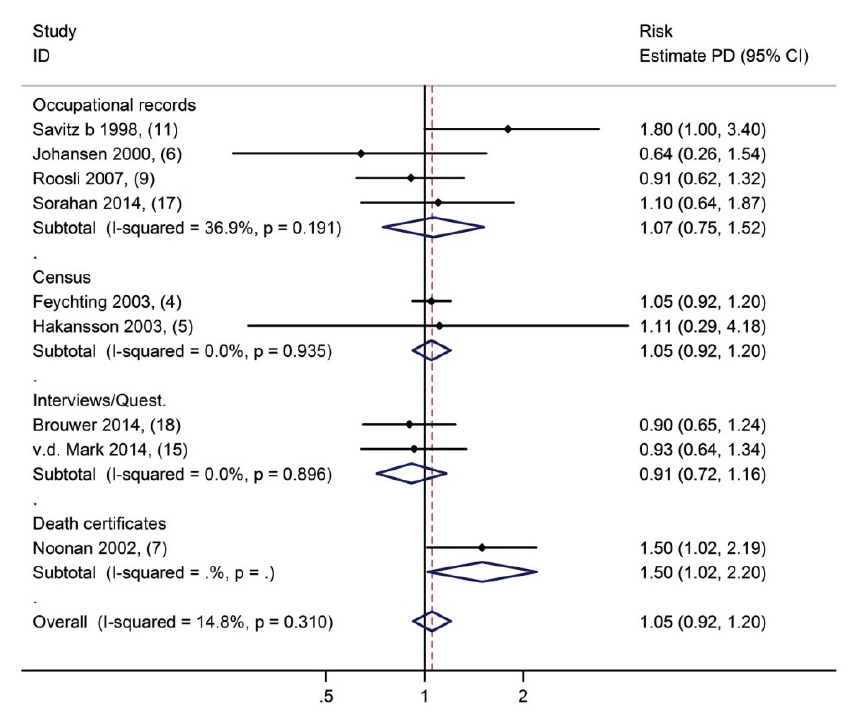
Figure 1. Parkinson’s disease in association with occupational exposure to extremely-low-frequency magnetic fields. Comparing higher to lowest exposure to extremely-low-frequency magnetic fields (Numbers in brackets pertain to references).